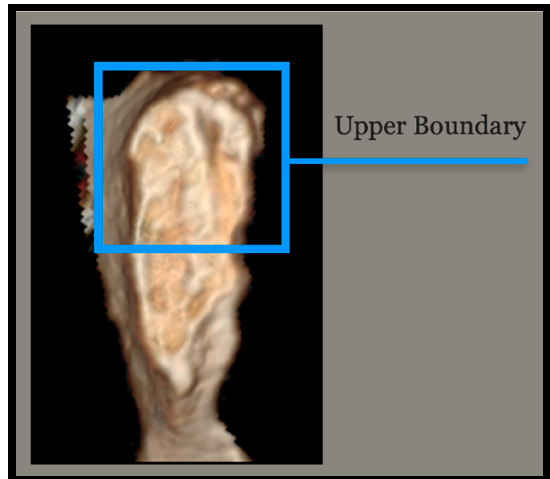
Figure 2. The Upper Boundary.